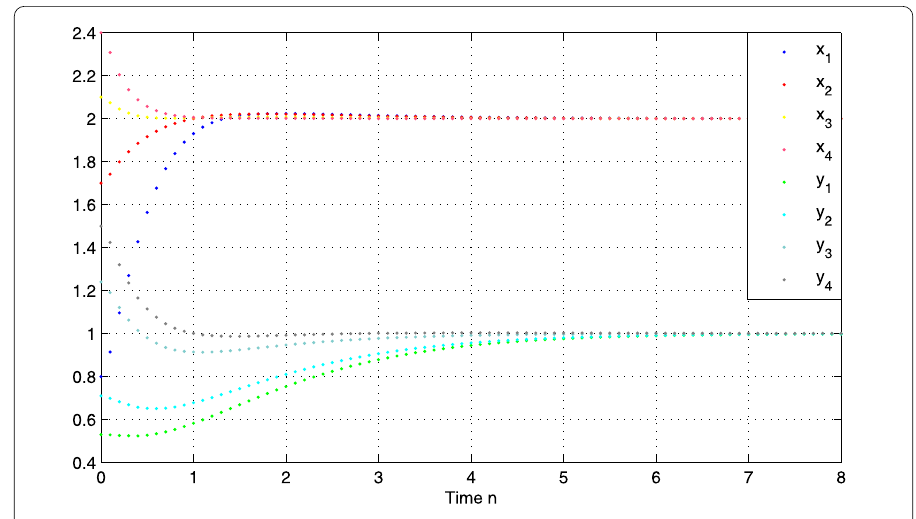
Figure 2 A structure for system (3) on four patches with the dispersal of prey denoted by digraph ( G , ˜ A